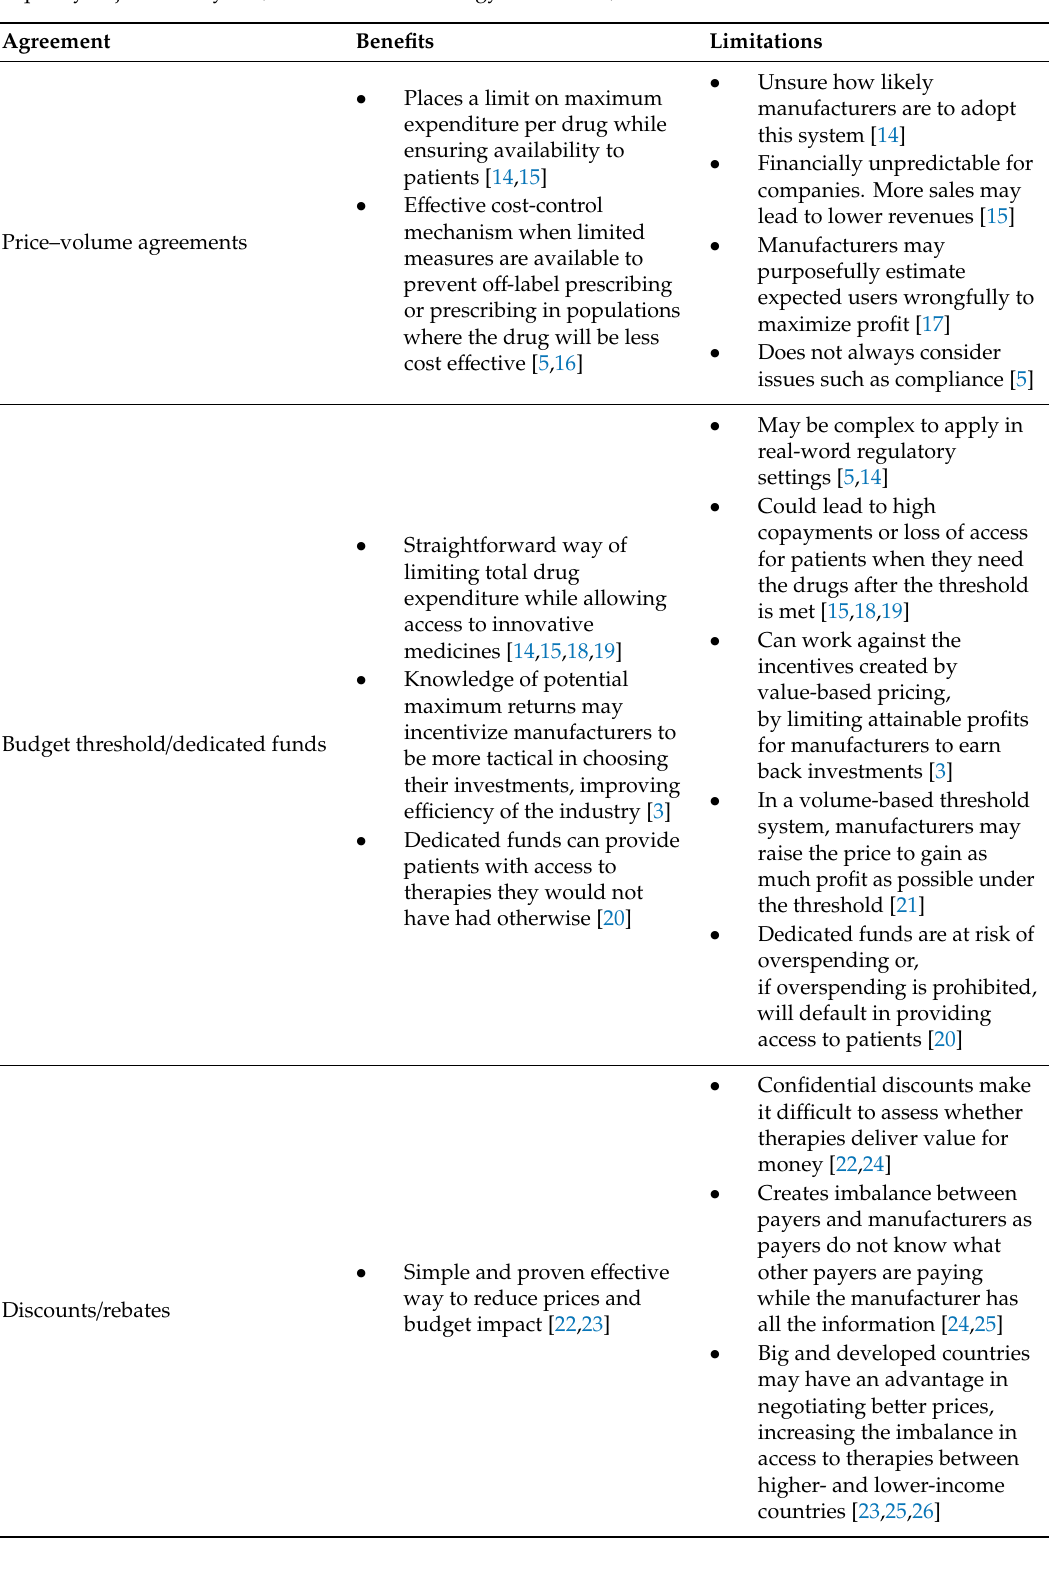
Table 2. Benefits and limitations of each of the included managed entry agreements.